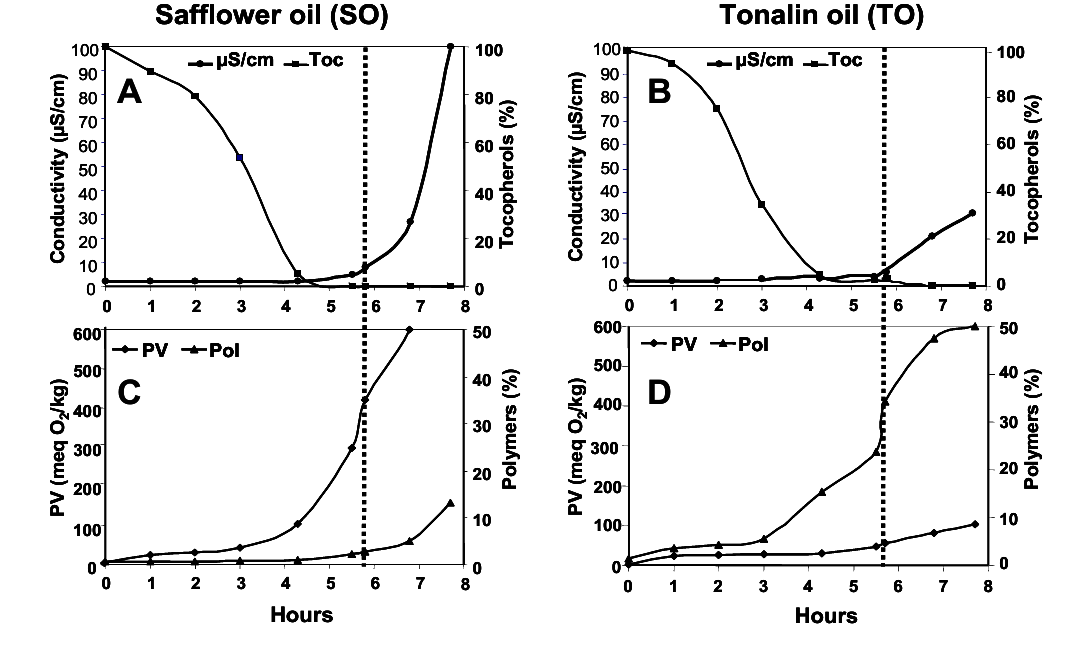
Figure 1. Oxidation of Safflower ( A , C ) and Tonalin ( B , D ) oils at 100 °C in Rancimat. Data are expressed as Means ( n = 3 experiments). Coefficients of variation were equal to or lower than 8% for peroxide values and tocopherols, and 5% for polymers. PV: peroxide value, POL: polymers, Toc: tocopherols.